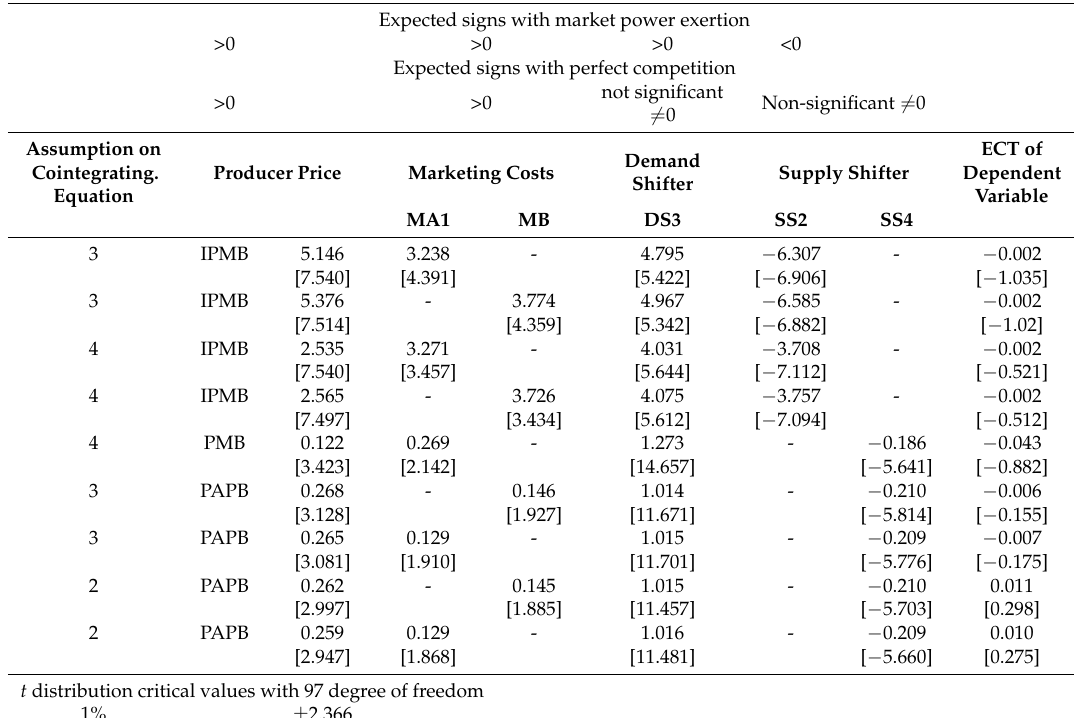
Table 3. Dataset B (January 2000–October 2008). ECM cointegrating vectors parameters [ t values] normalized with respect to retail.